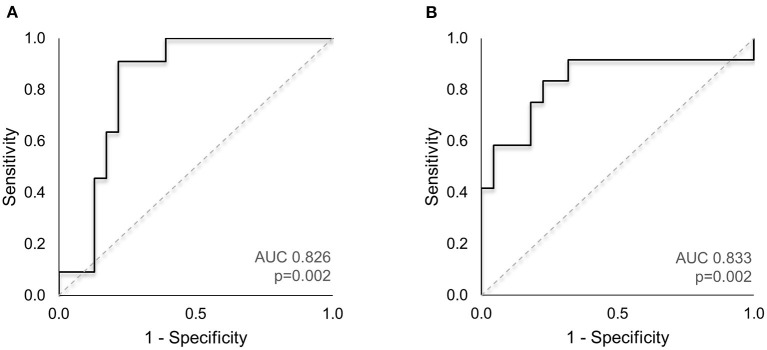
ROC analysis of ON imaging markers to identify subjects with enlarged CSF spaces. (A) The AUC for the optimal predictive model to identify subjects with abnormally enlarged frontal SAS (combination of ON width, length and tortuosity index) demonstrated good classification performance (AUC = 0.826, p = 0.002). (B) The best predictive model to detect subjects with abnormally enlarged interhemispheric fissure (ON width and tortuosity) showed a good diagnostic value (AUC = 0.833, p = 0.002). AUC, area under the curve; CSF, cerebrospinal fluid; ROC, receiver operating characteristic; SAS, subarachnoid space.